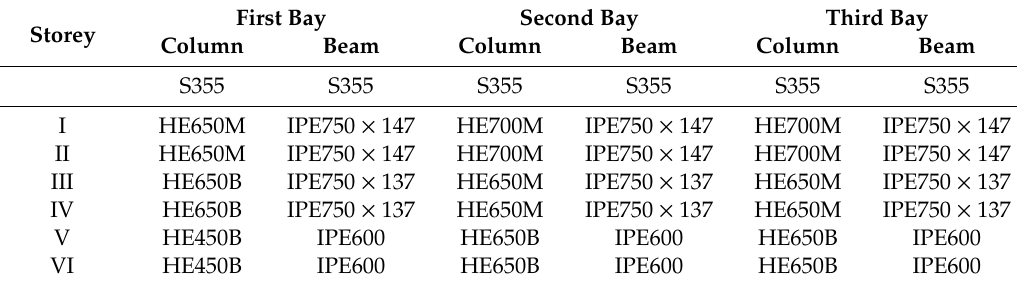
Table 4. Structural members for 6-Story